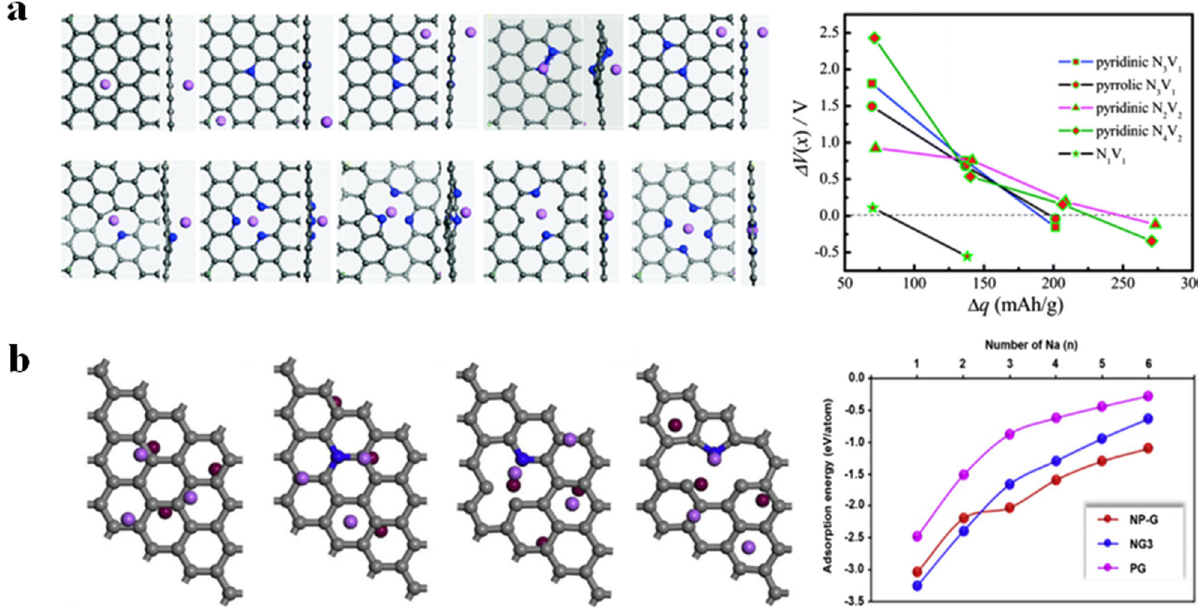
Fig. 11 Computational results of NDG in battery applications. a Optimized structures of a Li atom adsorbed on pristine graphene and N-substituted graphene (N 1 , N AA 2 , N AB 2 , N AB ’ 2 ,) N 1 V 1 , pyridinic-N 3 V 1 , pyrrolic-N 3 V 1 , pyridinic-N 2 V 2 , and pyridinic-N 4 V 2 defects, where N x V y denotes a con fi guration with x N atoms and y vacancies in graphene. The gray, blue, and pink balls represent C, N, and Li atoms, respectively (reproduced from 105 with permission from the Royal Society of Chemistry). b Optimized structures of six Na atoms adsorbed on pristine graphene and graphitic-N, pyridinic-N, and pyrrolic-N-type NDG. (reproduced from 121 with permission from Elsevier).